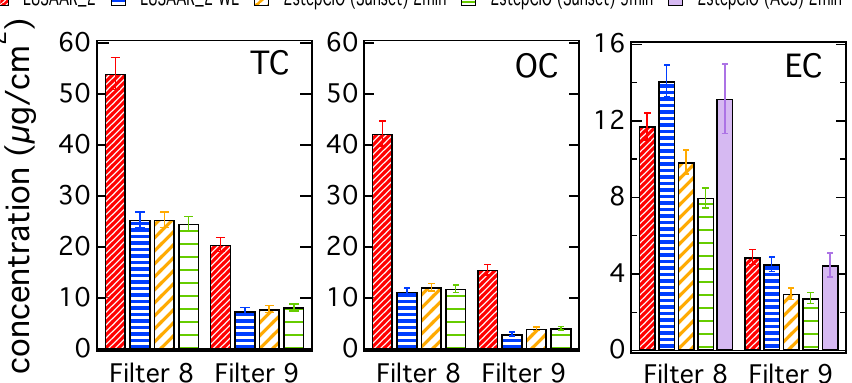
Figure 1. TC, OC and EC concentrations determined with the EUSAAR_2 protocol on untreated (EUSAAR_2) and water-extracted (EUSAAR_2 WE) filter samples and determined with the 2stepCIO protocol on the Sunset analyzer with an intermediate step (450 ◦ C) of 2 min (2stepCIO (Sunset) 2min) and 3min (2stepCIO (Sunset) 3min) and the 2stepCIO protocol on the aerosol combustion system (ACS) (2stepCIO (ACS) 2min) for a five-day filter (8) and a two-day filter (9). The different bars represent carbon concentrations determined with the EUSAAR_2 protocol, extraction system (purple). The EUSAAR_2 protocol has been applied to the untreated filter samples (EUSAAR_2 in red) and to the water-extracted filter samples (EUSAAR_2 WE in blue). The 2stepCIO protocol on the Sunset instrument has been applied with an intermediate step (450 ◦ C) of 2 min